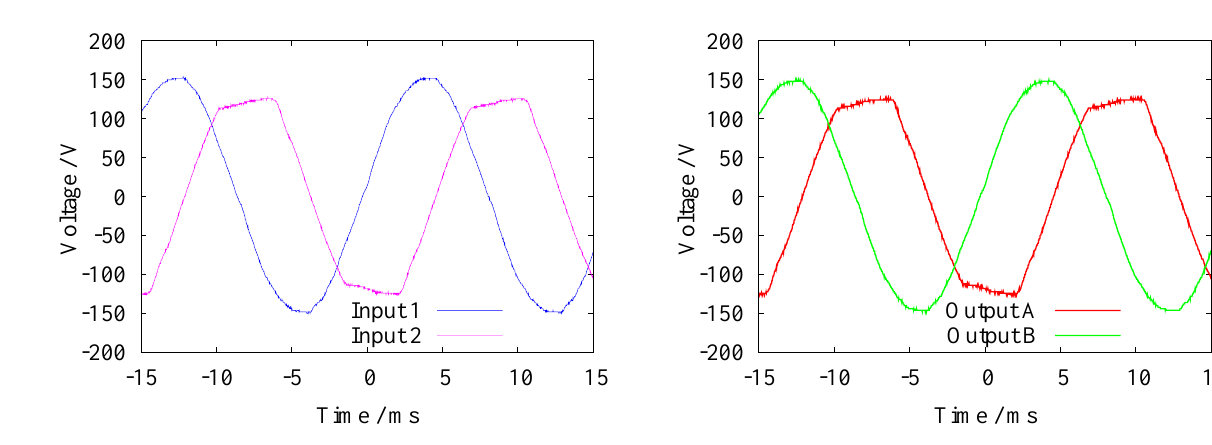
Figure 6. Input and output voltage waveforms of power